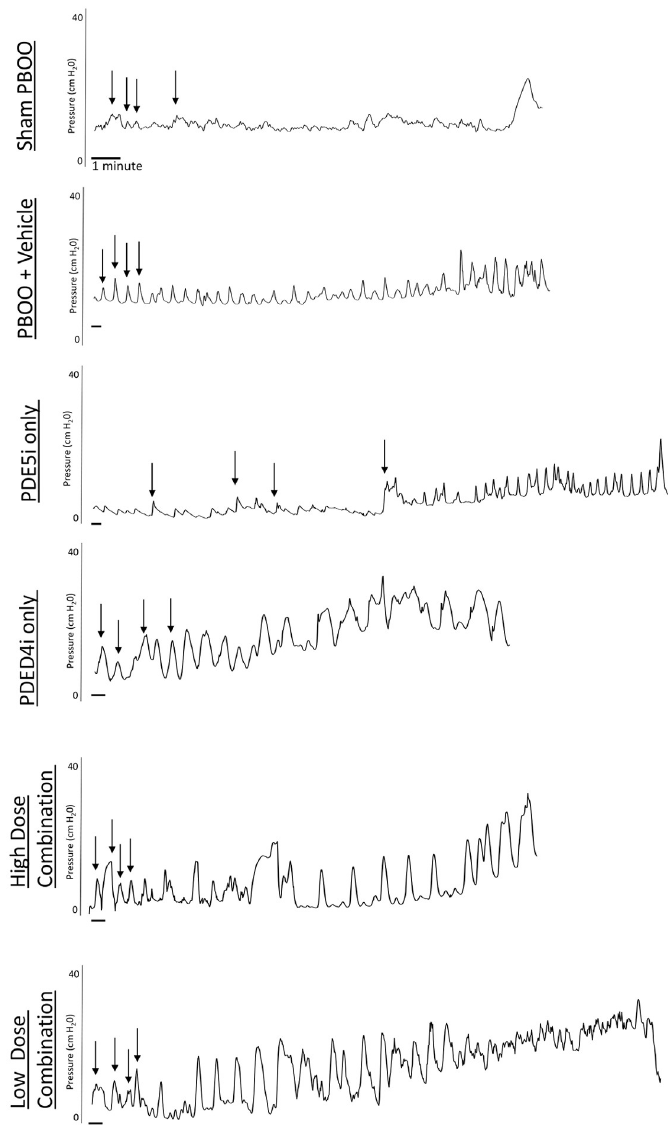
Fig 1. Examples of bladder pressure during conscious cystometry in rats receiving: Sham partial bladder outlet obstruction (PBOO) + vehicle (SPBOO + V) (A), PBOO + vehicle (PBOO + V) (B), PBOO + PDE5i (C), PBOO + PDE4i (D), PBOO + high dose combination treatment (E), and PBOO + low dose combination treatment (F). The scale bar indicates 1 minute. Arrows indicate four example non-voiding contractions.